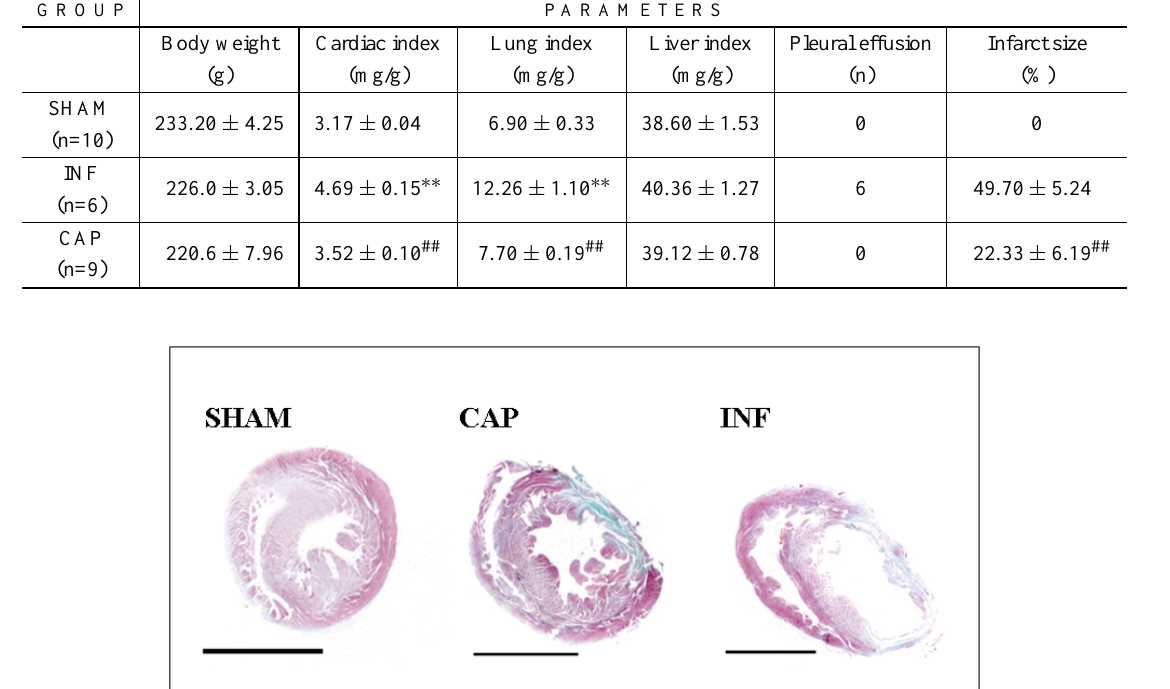
Post-mortem study performed in SHAM, INF and CAP 28 days after surgery. Data are means ± SEM. n = number of rats. ∗∗ P < 0 . 01 vs. SHAM. ## P < 0 . 01 vs. INF.